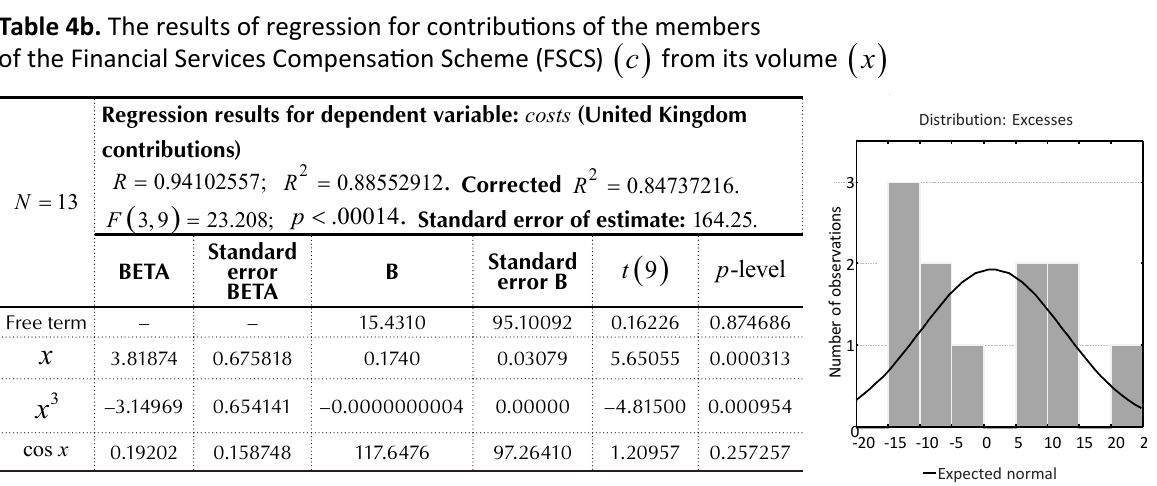
Table 4c. The results of regression for operating costs of the Financial Services Compensation Scheme (FSCS) ( ) e from the volume of the fund Regression results for dependent variable: costs (data matrix